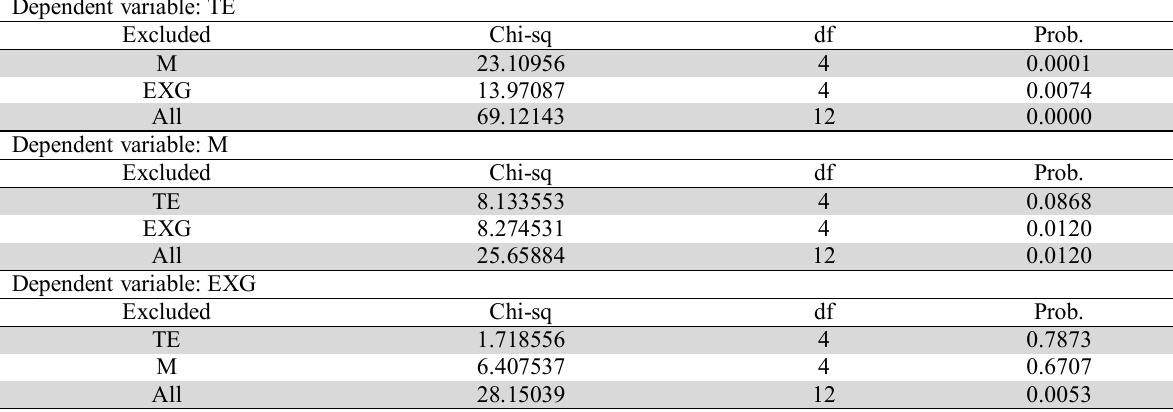
The summary of Chi-Square